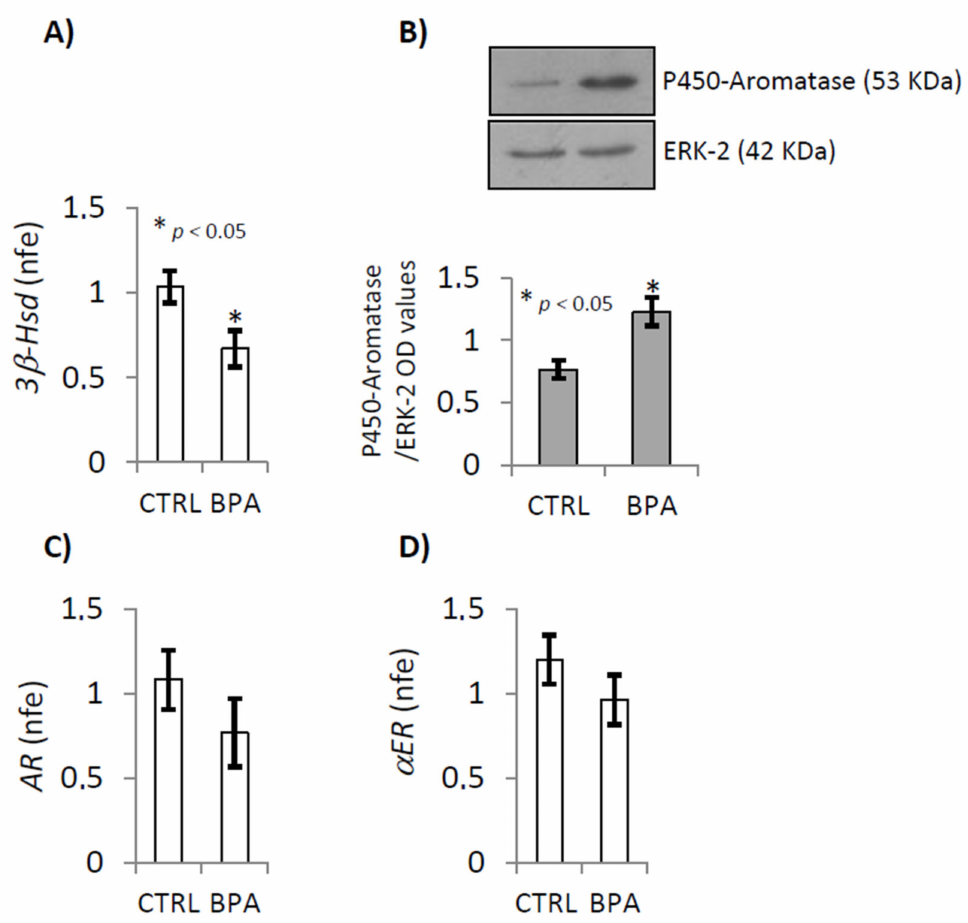
Figure 2. RTqPCR analysis of testicular 3 β -Hsd ( A ), AR ( C ) and α ER ( D ) mRNA in CTRL and BPA exposed mice. Transcripts amounts were reported as normalized fold expression (nfe) relatively to Rps18 gene ( A , C , D ). Western Blot analysis of P450-aromatase ( B ) in CTRL and BPA exposed mice. Protein amounts were quantified by densitometry analysis, normalized against ERK-2 signals, and expressed in OD values as fold change ( B ). All data were reported as mean value ± S.E.M. (*: p <